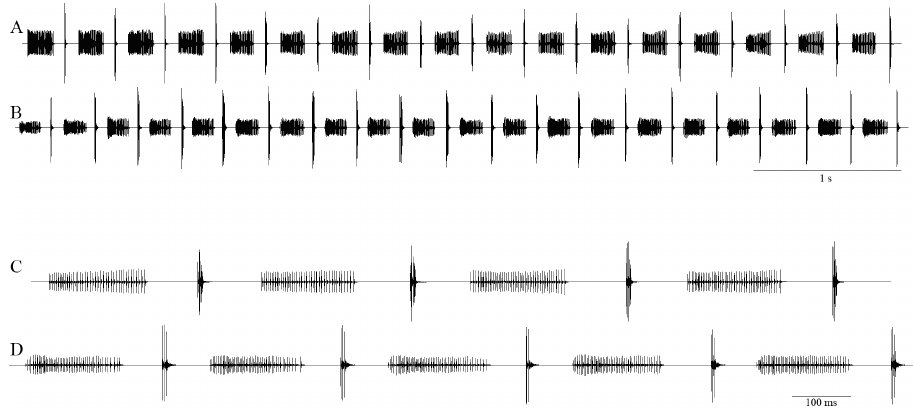
Figure 3. Oscillographic representation of the calling songs ( A, B ) of two males of Isophya bucovinensis sp. n. and detailed syllables ( C, D ). A, C Călimani Mountains, 12 Apostoli peak, 1730 m asl (air tem- perature 24°C) B, D Suhard Mountains, Omu peak, 1860 m asl (air temperature 25°C).